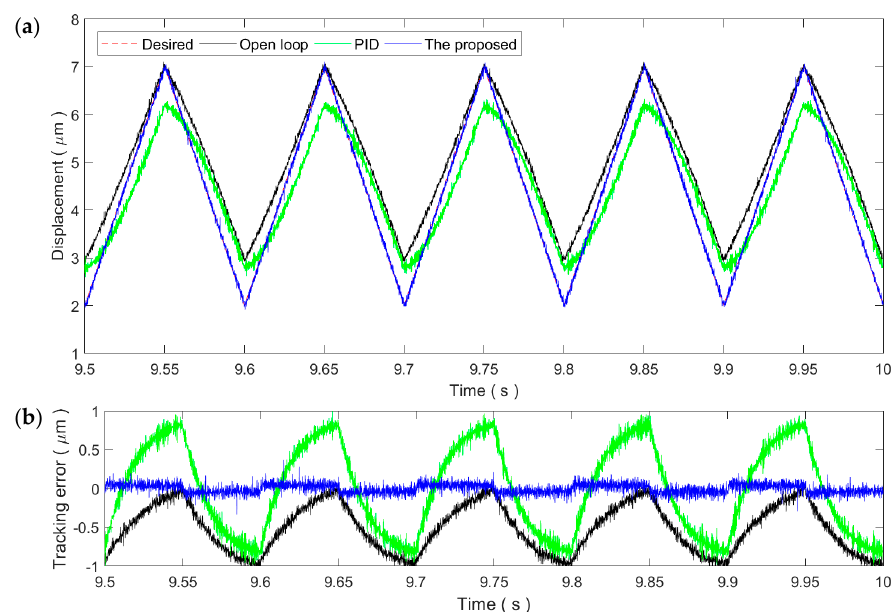
Figure 9. Tracking of the 10 Hz triangular trajectory: ( a ) Time plot and ( b ) tracking error.